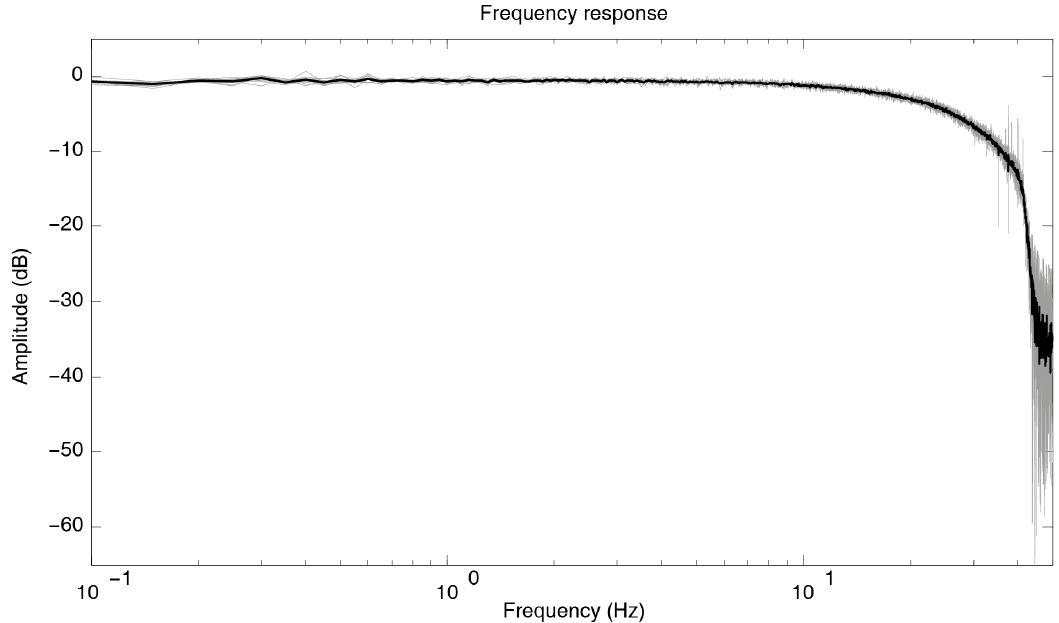
Figure 13. Frequency response of the 12 analyzed ACN modules (light gray), together with the average frequency response (black line).